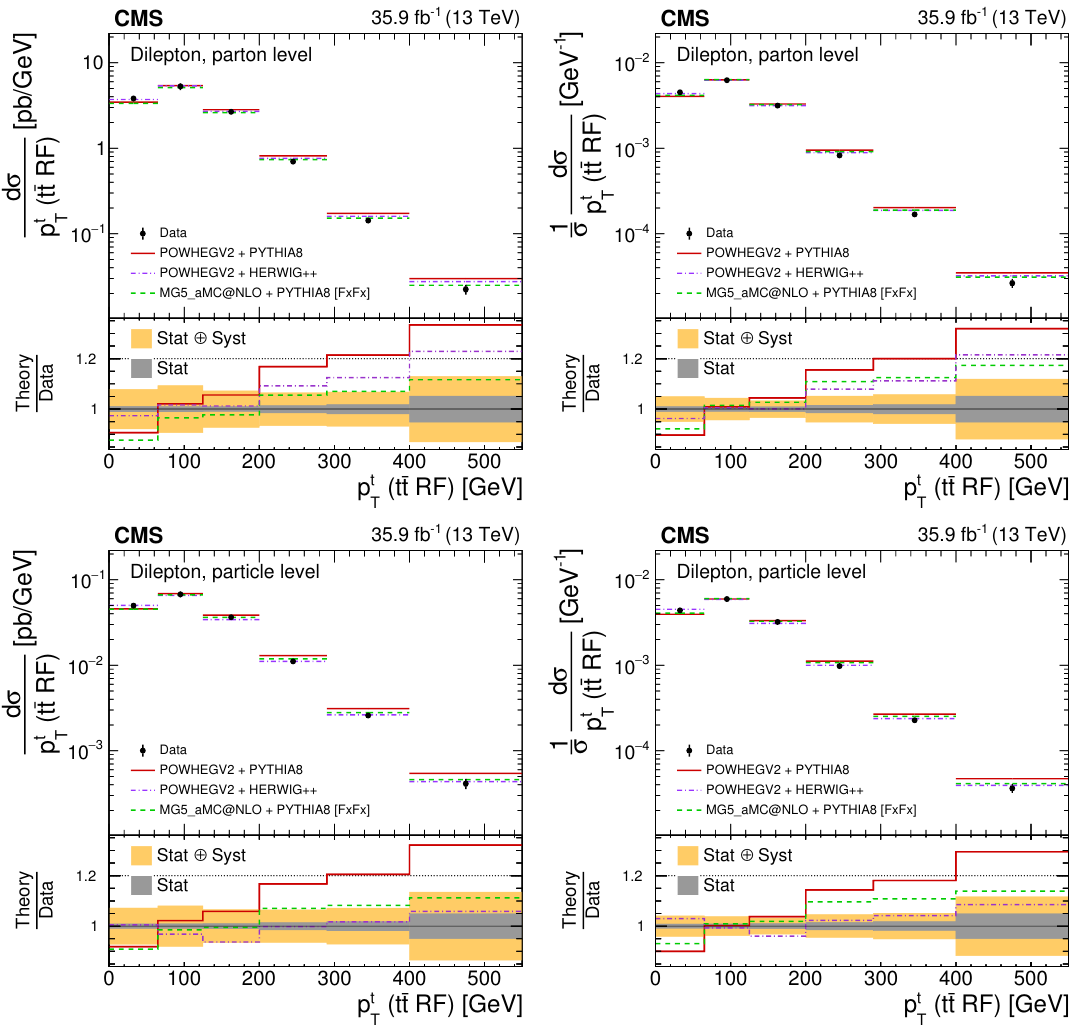
Figure 11 . The di(cid:11)erential tt production cross sections as a function of p t for the data (points) and the MC predictions (lines). The vertical lines on the points indicate the total uncertainty in the data. The left and right columns correspond to absolute and normalised measurements, respectively. The upper row corresponds to measurements at the parton level in the full phase space and the lower row to the particle level in a (cid:12)ducial phase space. The lower panel in each plot shows the ratios of the theoretical predictions to the data. The dark and light bands show the relative statistical and total uncertainties in the data, respectively.